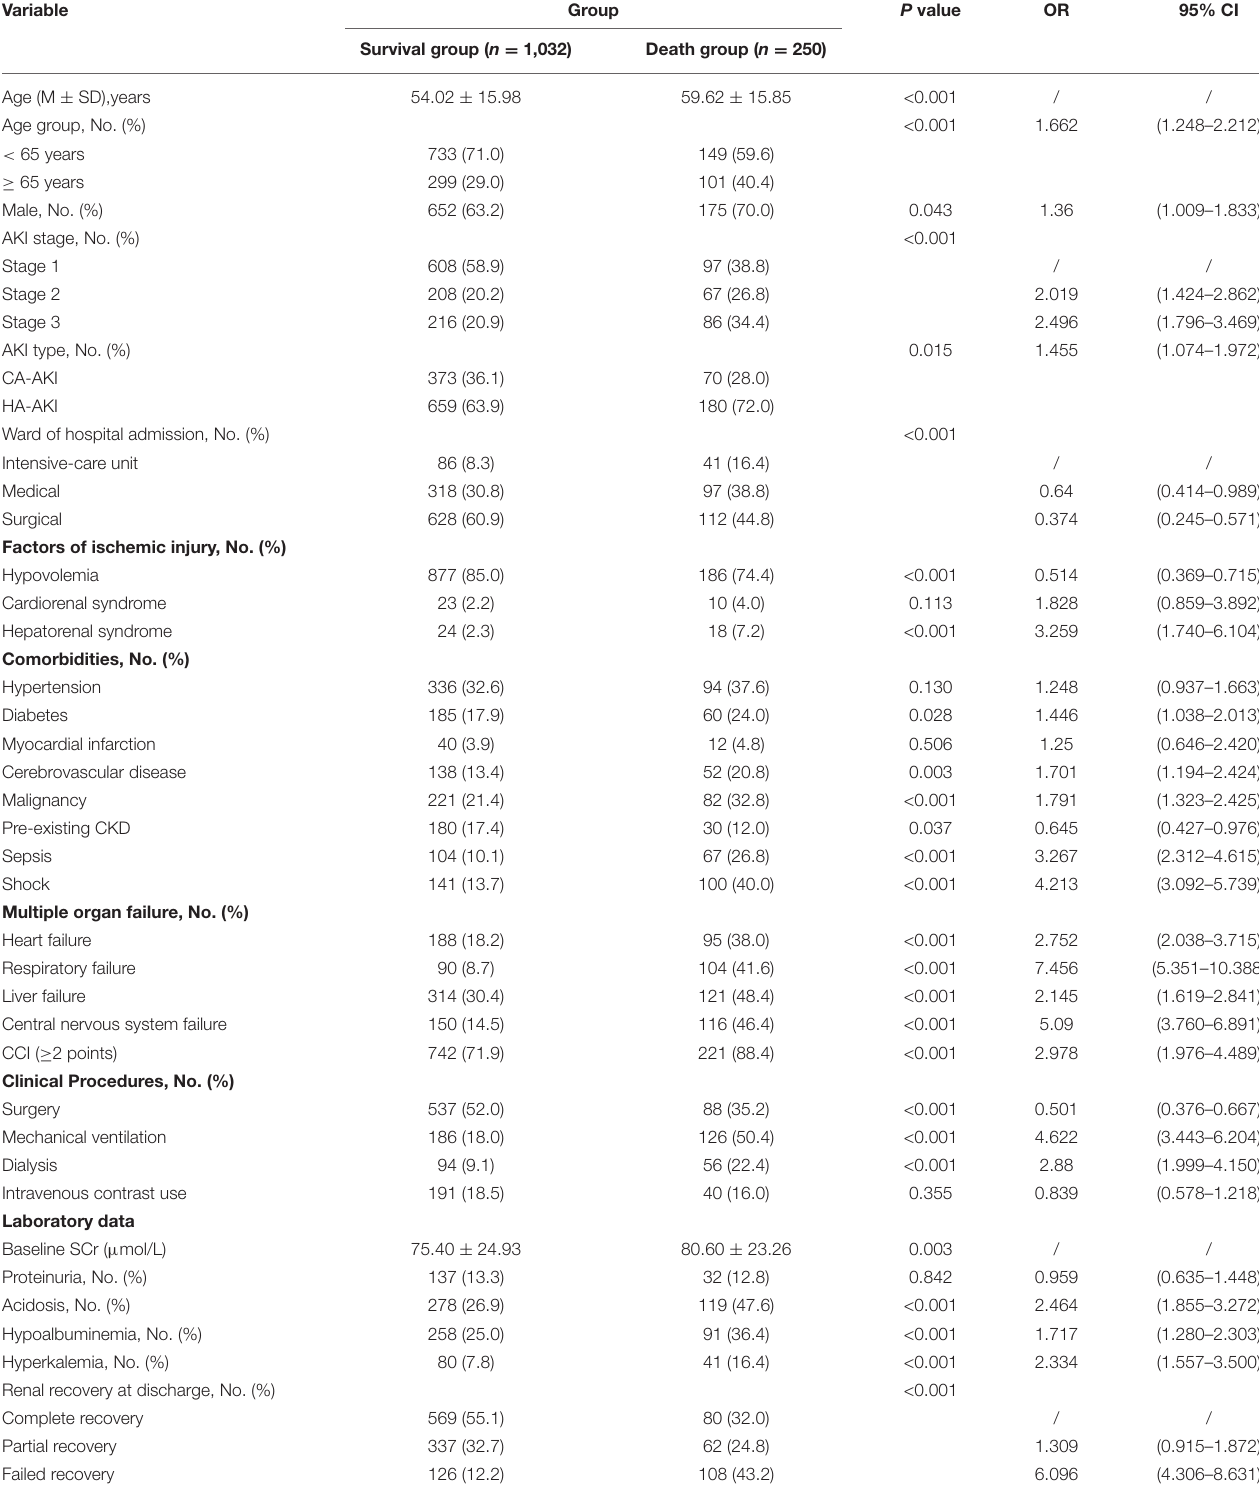
TABLE 5 | Characteristics of the study population stratified by 1-year survival status in the training cohort.